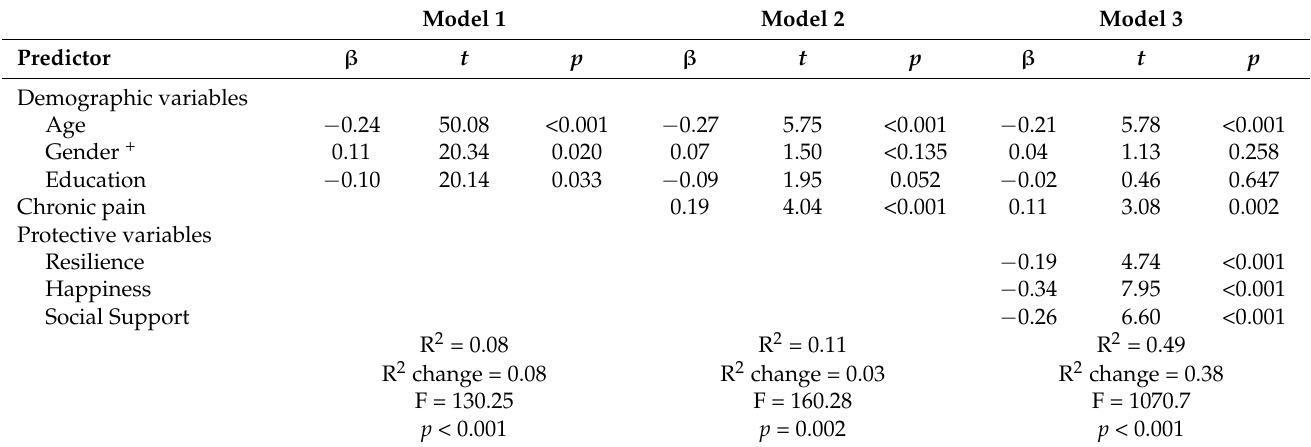
Table 5. Regression analyses predicting depression.